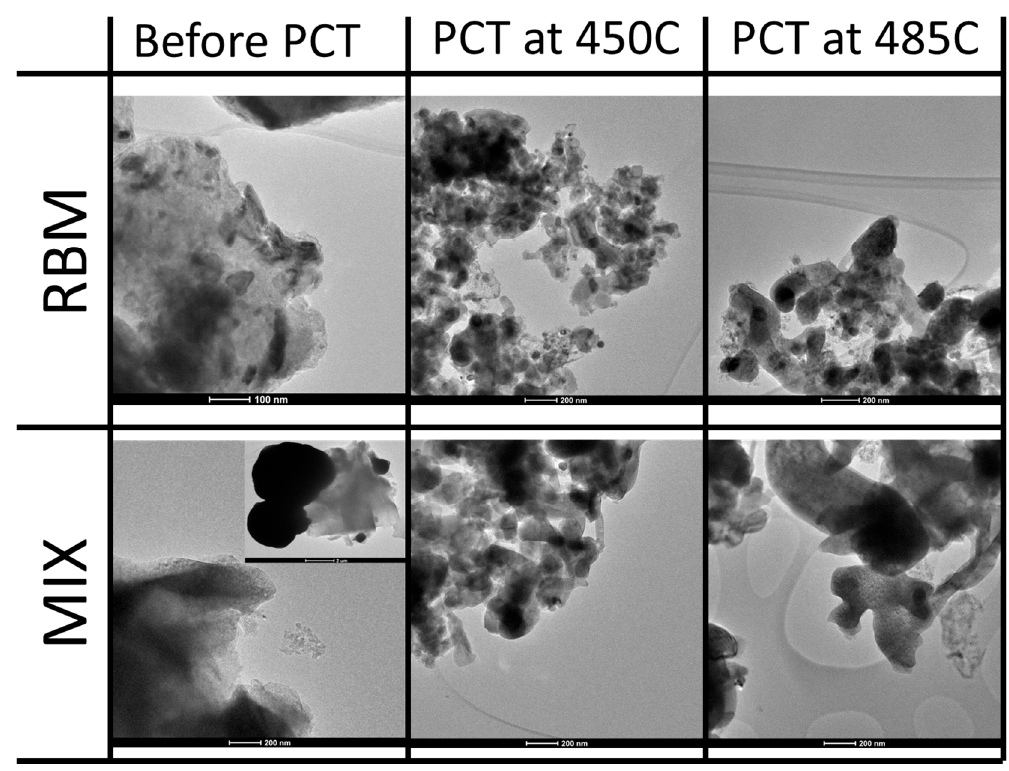
Figure 3. Evolution of the morphology for the two series of samples, i.e., RBM and MIX, before hydrogen sorption and after H 2 sorption at two temperatures.